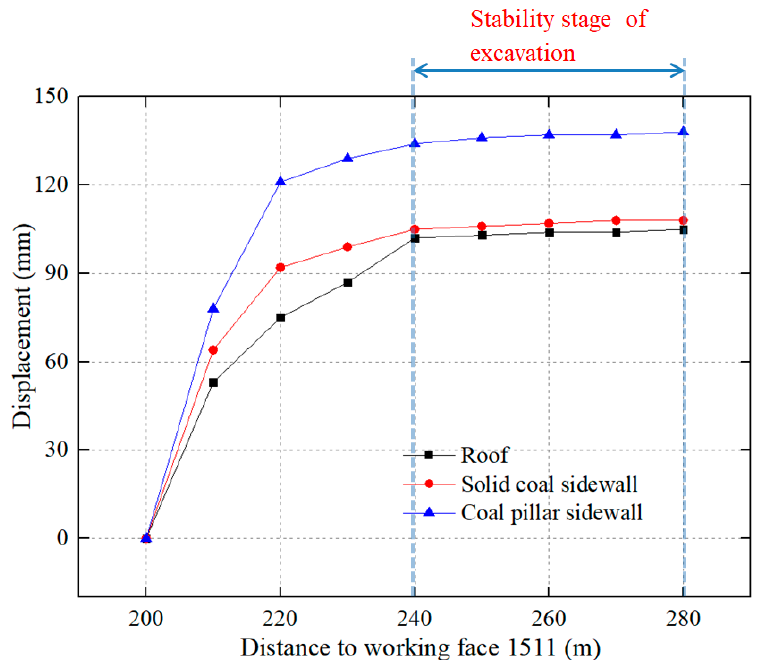
Figure 15. Surface displacement law of surrounding rock in zone C of MTR 1513.